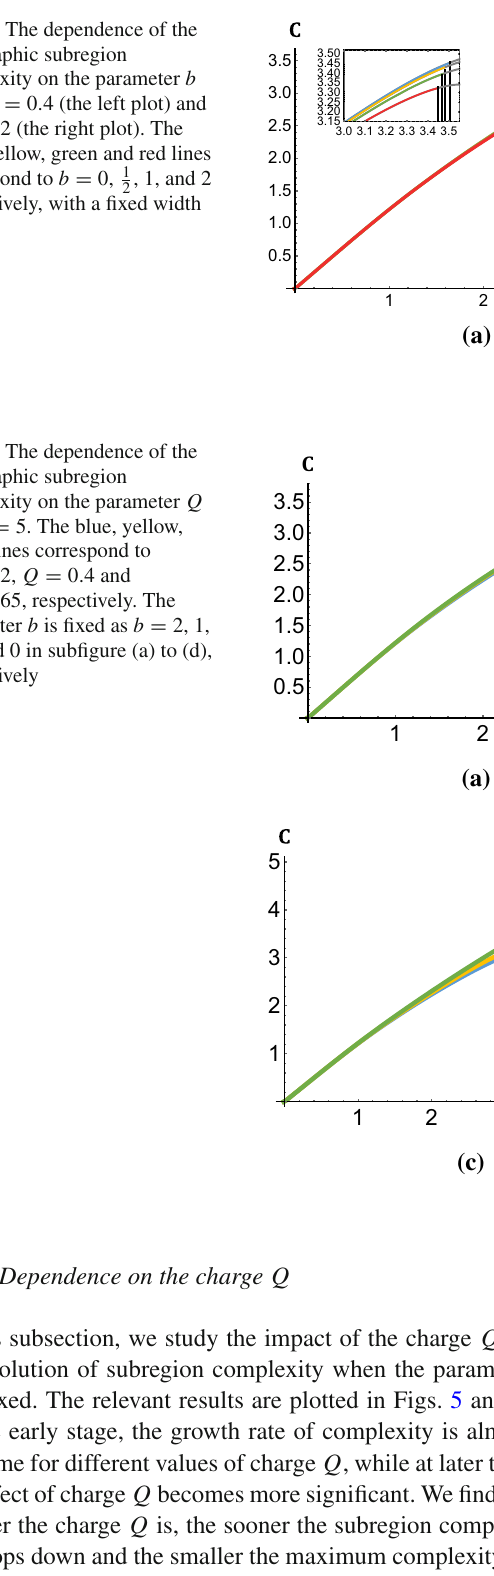
Fig. 4 The dependence of the holographic subregion complexity on the parameter b with Q = 0 . 4 (the left plot) and Q = 0 . 2 (the right plot). The blue, yellow, green and red lines correspond to b = 0, 1 respectively, with a fixed width l = 5